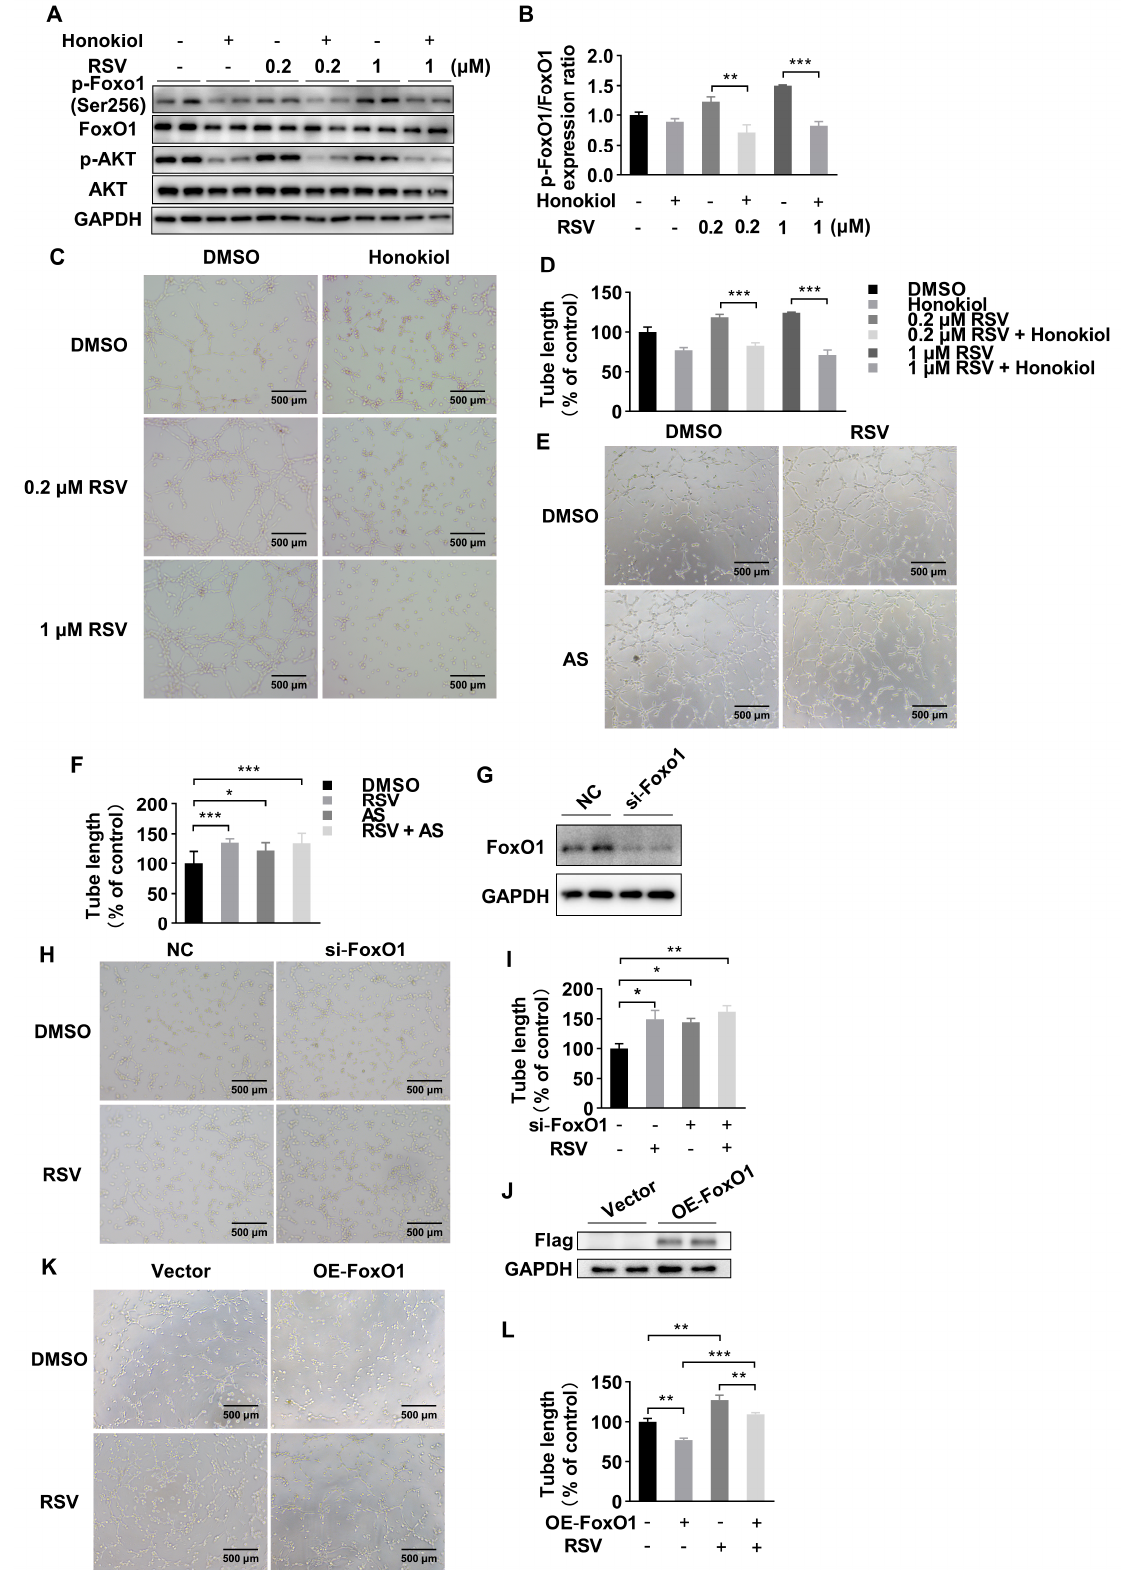
Figure 3. RSV improved the angiogenesis of HUVECs in a FoxO1-dependent manner. ( A ) The expression of phosphorylated FoxO1, FoxO1, phosphorylated Akt and Akt after RSV or/and honokiol treatment. ( B ) Quantitative analysis of Western blot. Data were shown as mean ± SEM (** p < 0.01; *** p < 0.001). ( C ) The tube formation assay was performed in